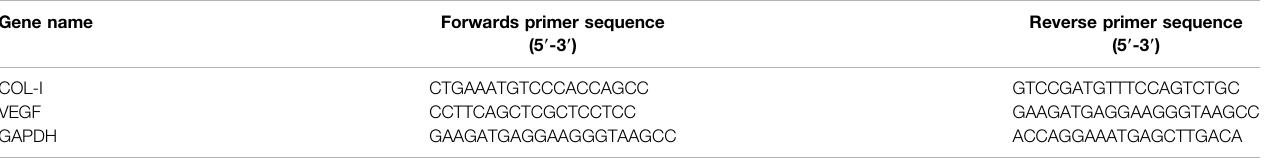
TABLE 1 | List of genes and primer nucleotide